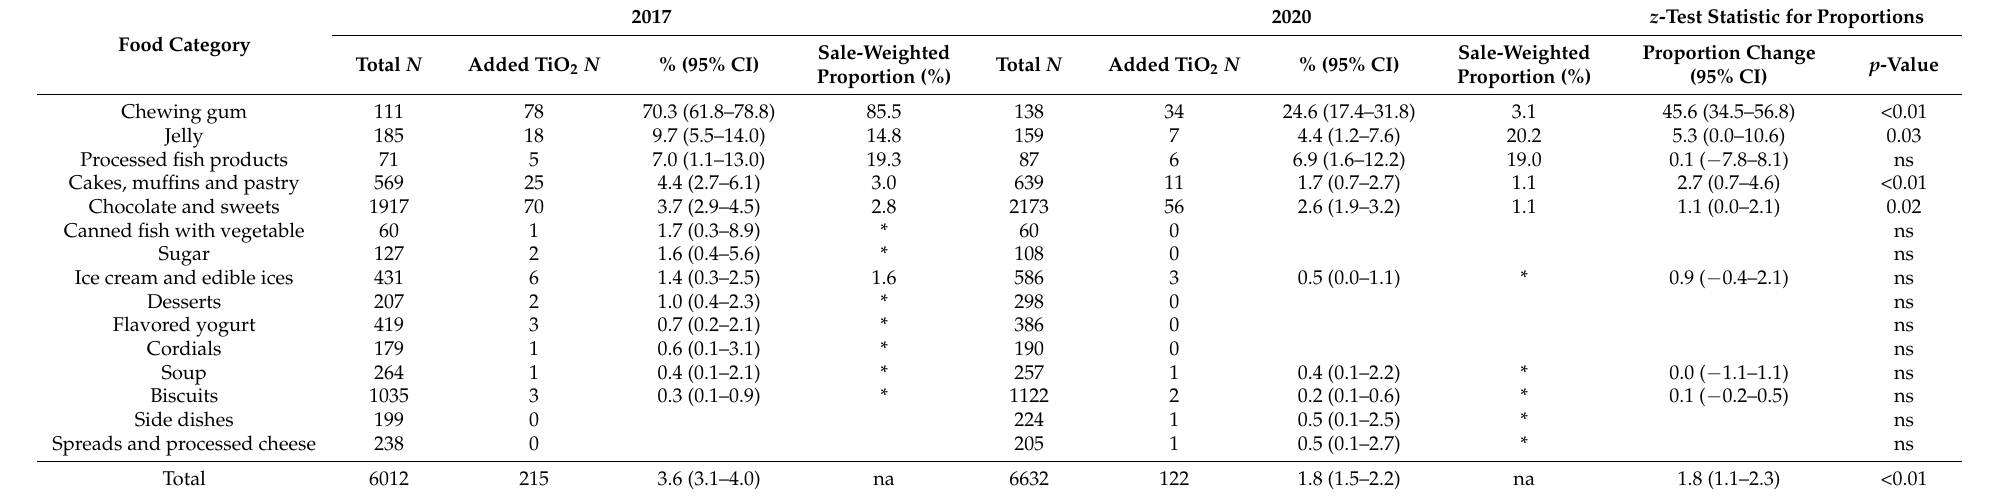
Table 1. (Sub)category proportions of foods containing TiO 2 (E171) as food additive in the food supply for 2017 and 2020